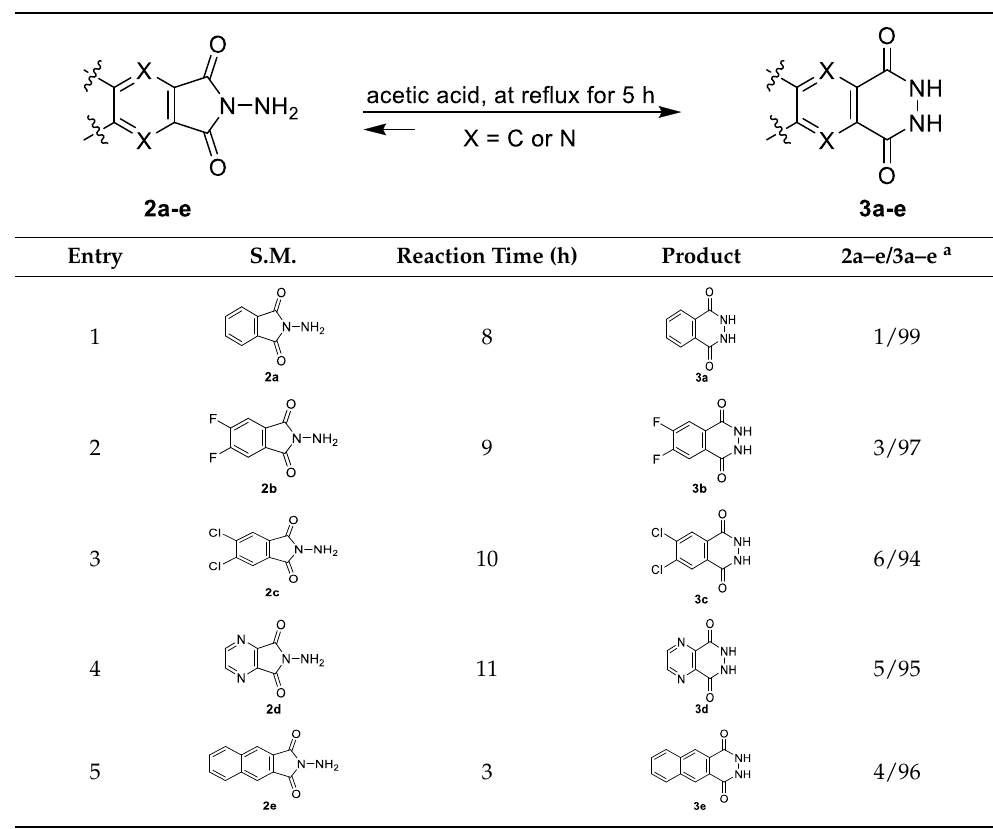
Molecules 2021 , 26 , x FOR PEER REVIEW